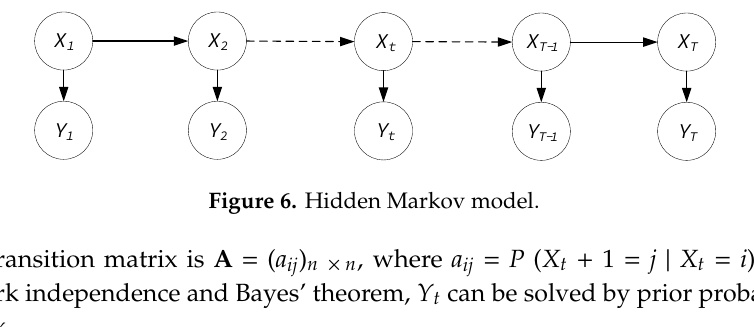
E 2 D 2 Figure 5. Three-phase generation expansion planning network representation.